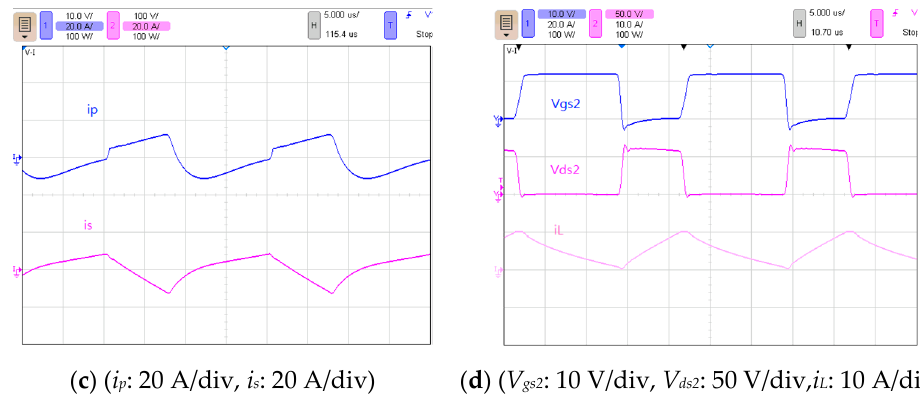
Figure 13. Measured waveforms under Stage 3 at half load: ( a ) switch S 3 waveform, ( b ) switch S 4 waveform, ( c ) current waveform of transformer, and ( d ) switch S 2 waveform and charging inductor current waveform.